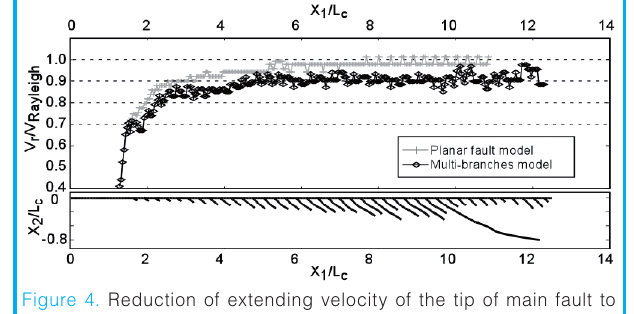
Figure 4. Reduction of extending velocity of the tip of main fault to approximately a constant sub-Rayleigh value due to multiple branching; the model shown in Figure 4 is assumed. (Upper) Black curve denotes the fault tip velocity in the multi-branch model. Gray curve shows the case of planar fault model with no branches; the other assumptions are the same as in the multi- branch model. (Lower) Thick curves denote the corresponding fault geometry of the multi-branch model (after Ando and Yamashita, 2007).